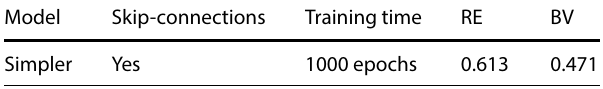
Table 5 AUROC scores calculated on KITTI